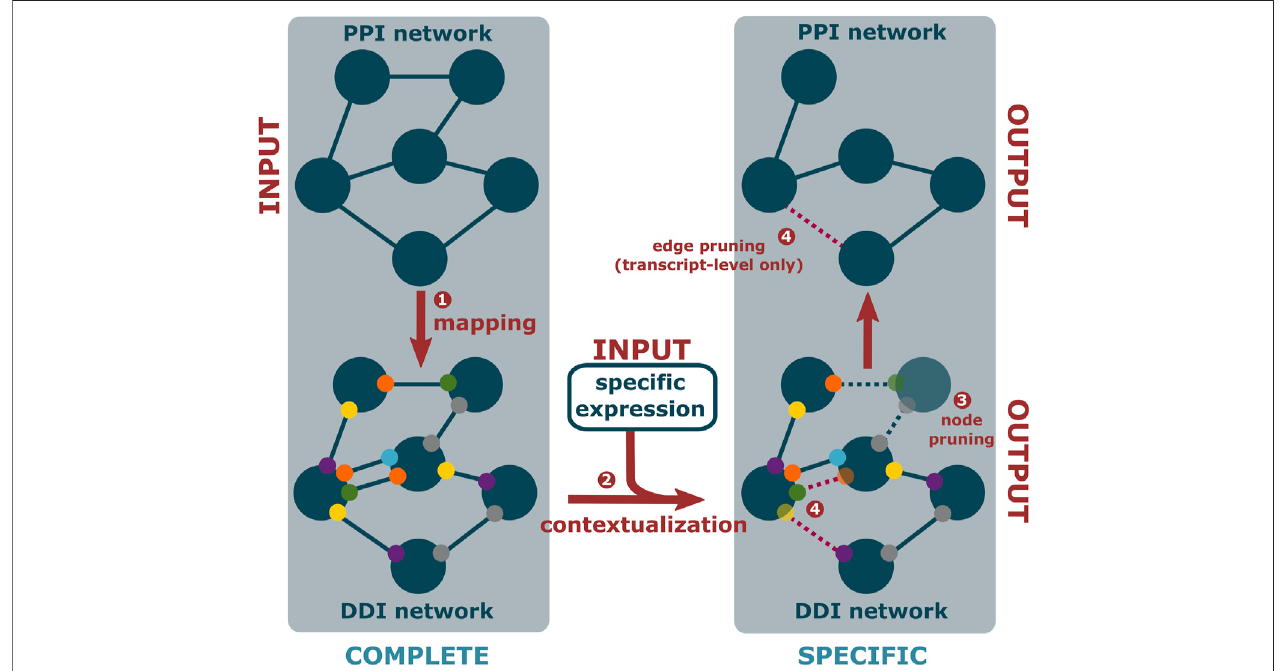
FIGURE2| PPIXpress fi rsttakesacomplete PPInetwork(dark bluenodes)and associateseach interaction (solidedges)withknowninteractionsbetweenprotein domains (smaller, colorful nodes) or, if unknown, between arti fi cial domains (grey nodes) (1). Then, based on provided expression data (2), proteins that are not expressed and domainsthatdonotoccurinthemostabundanttranscriptareremoved(translucent)(3),asarethenolongersupported edges(dotted lines)iftranscript- level data is available (4), resulting in a condition-speci fi c DDI and corresponding PPI